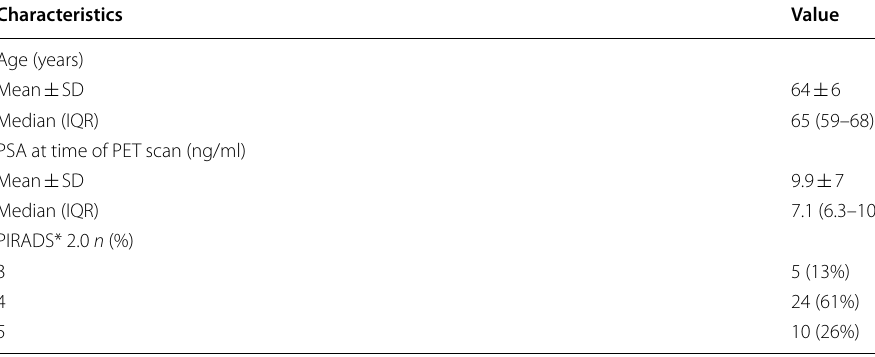
Table 1 Patient characteristics at study inclusion (n